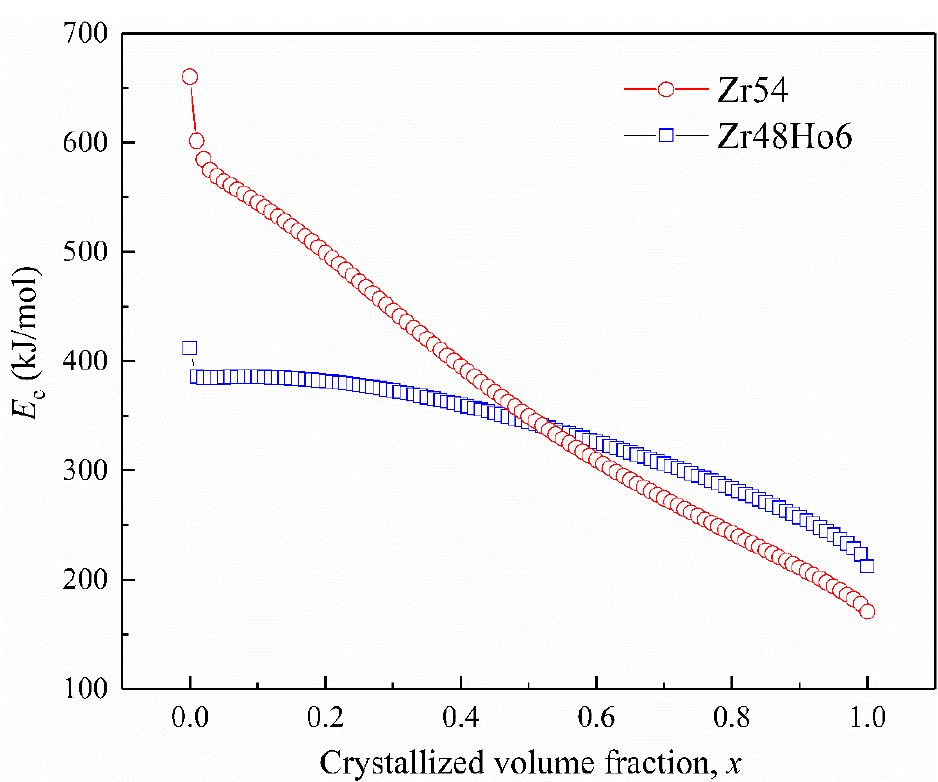
Figure 6. Local activation energies corresponding to crystallized fraction for Zr54 and Zr48Ho6 BMGs.